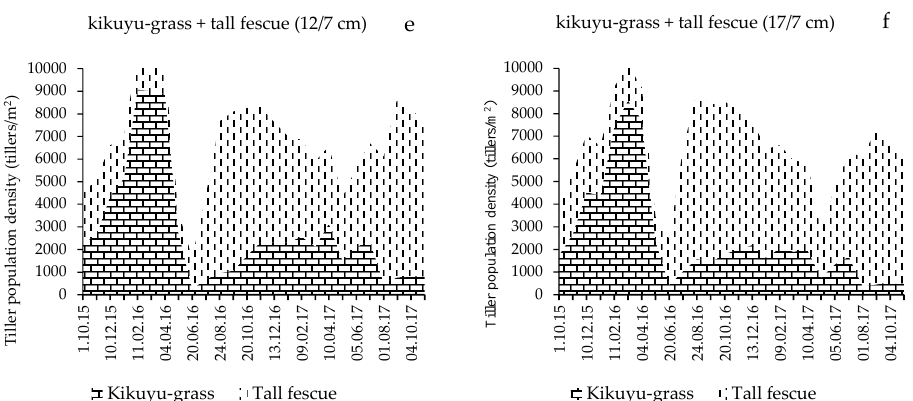
Figure 4. Cohort survival diagrams for tillers of kikuyu-grass ( a, b ) and tall fescue ( c, d ) cultivated in mixed canopies maintained at 12 and 17 cm and submitted to a single grazing to 7 cm in mid-autumn and their overlapping population demography ( e, f ).